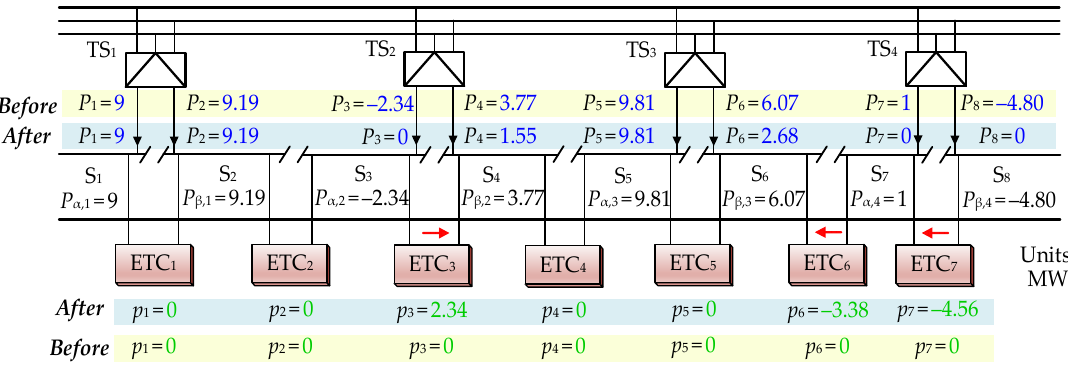
Figure 12. The feeder power and the transmission power of ETC 1 –ETC 7 before and after optimization by the algorithm.